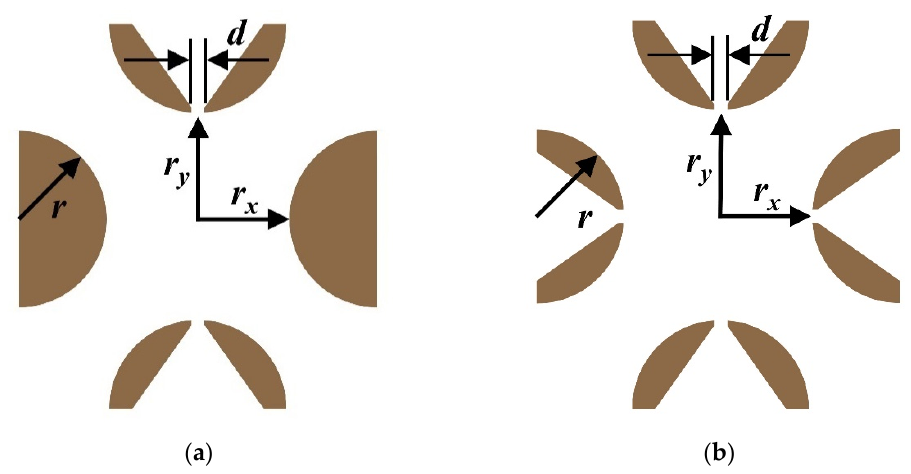
Figure 1. Cross-section of miniature HreLIT. ( a ) 2-slit model; ( b ) 4-slit